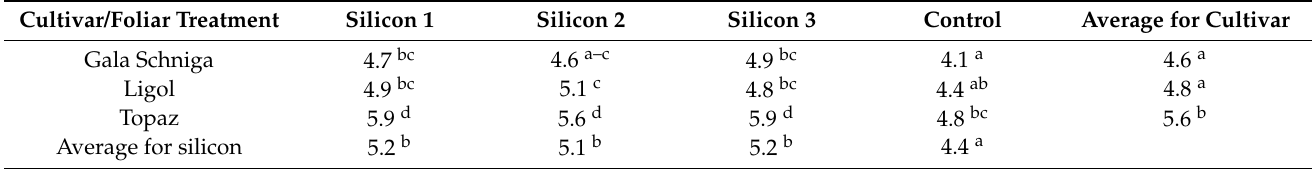
Table 7. The yield coefficient of apple trees depends on cultivar and foliar silicon treatment (kg · cm 2 ).